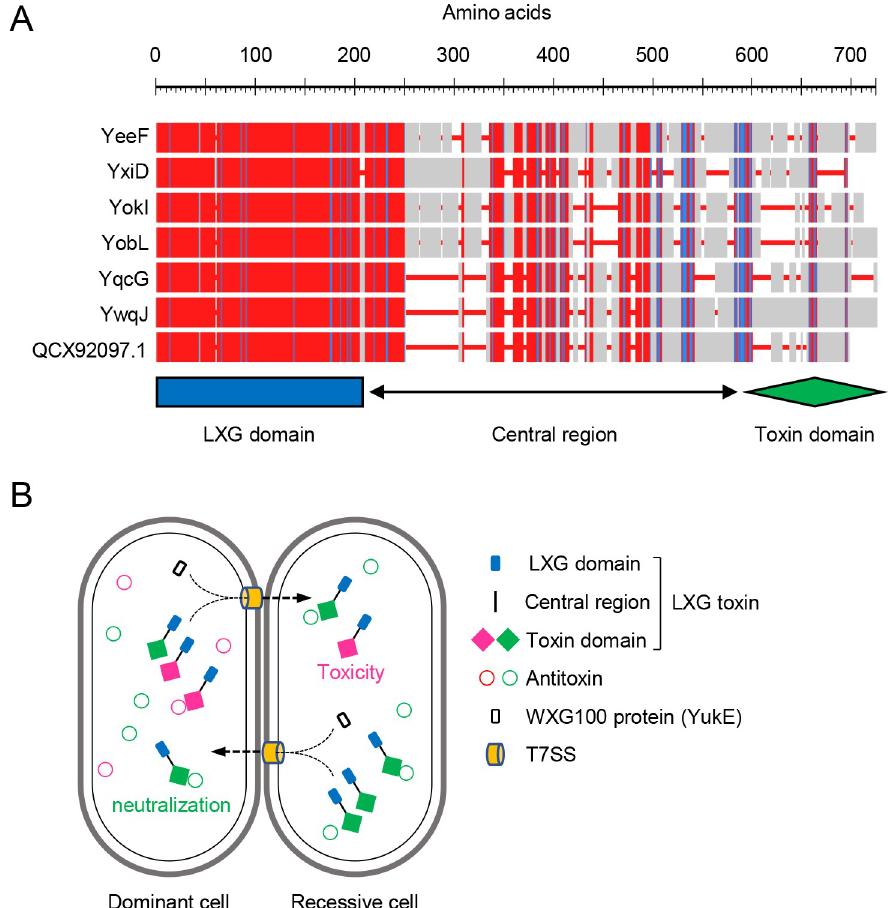
Fig 1. LXG toxins-antitoxin systems in B . subtilis . (A) Multiple alignment of LXG toxins from B . subtilis strain 3610. Alignment was constructed using NCBI COBALT (https://www.ncbi.nlm.nih.gov/tools/cobalt/re_cobalt.cgi) with default settings. Red indicates highly conserved positions and blue indicates lower conservation. Red lines are gaps in alignment. The location of the LXG domain, the central region, and the toxin domain are shown below the alignment. (B) Intercellular competition mediated by LXG toxin-antitoxin systems. LXG toxins are neutralized by cognate antitoxins in toxin producers. The WXG100 protein promotes the T7SS-dependent delivery of LXG toxins from producers to recipients. If recipients do not express cognate antitoxins, delivered LXG toxins exert toxic effects. Cognate toxin domains and antitoxins are shown by the same color.